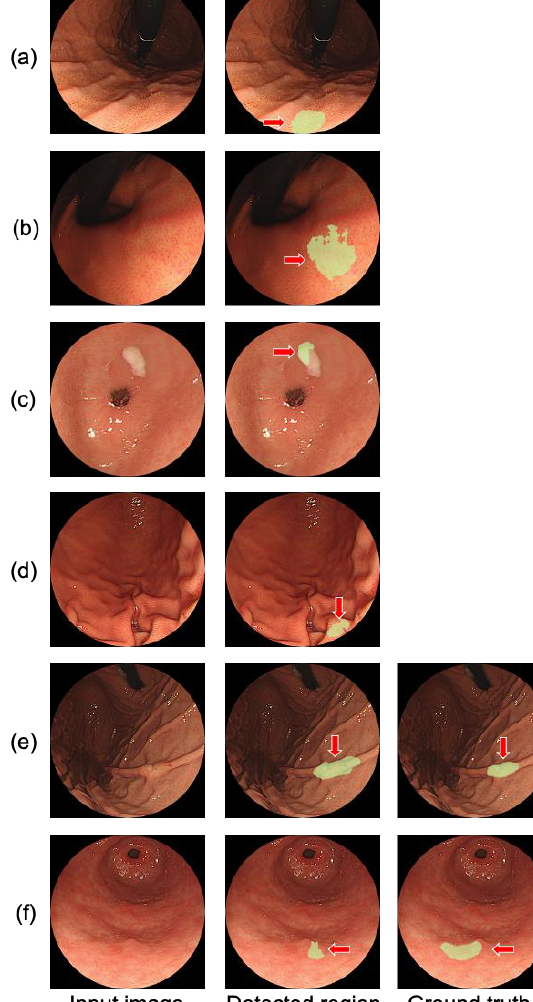
Figure 5. Example of the cropped images for false positive reduction: ( a ) Cropped images of cancer lesions; ( b ) Cropped images of false positives.